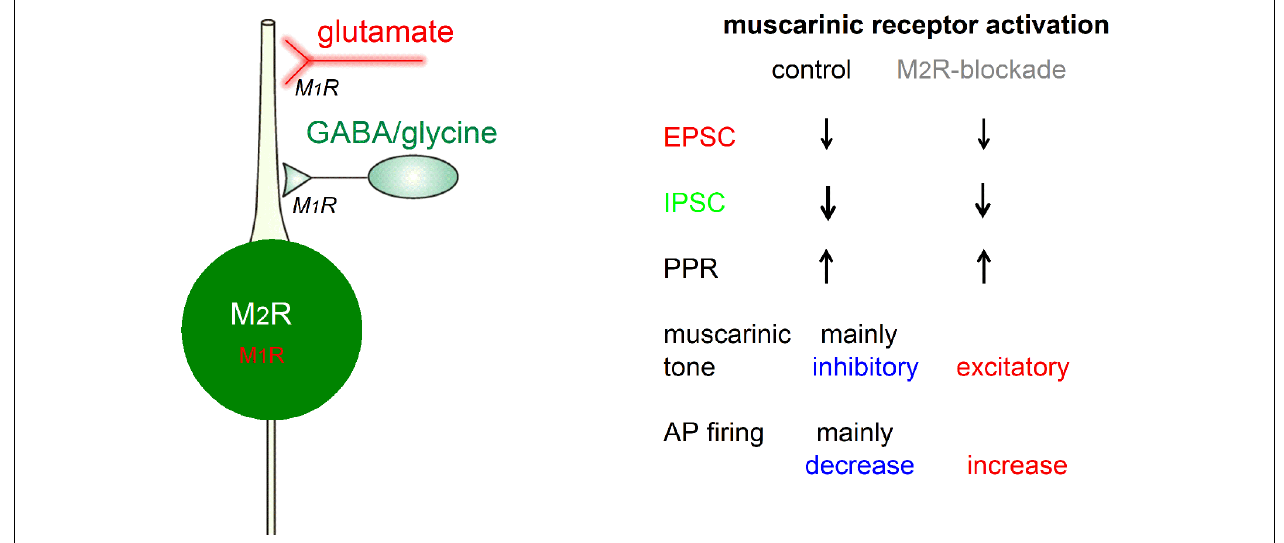
FIGURE 12 | Graphic summary of muscarinic effects on preBötC glycinergic neurons. For explanation see text. Abbreviations: AP, action potential; EPSC, excitatory postsynaptic current; IPSC, inhibitory postsynaptic current; M 1 R or M 2 R, muscarinic acetylcholine receptor type 1 or 2; PPR, paired-pulse